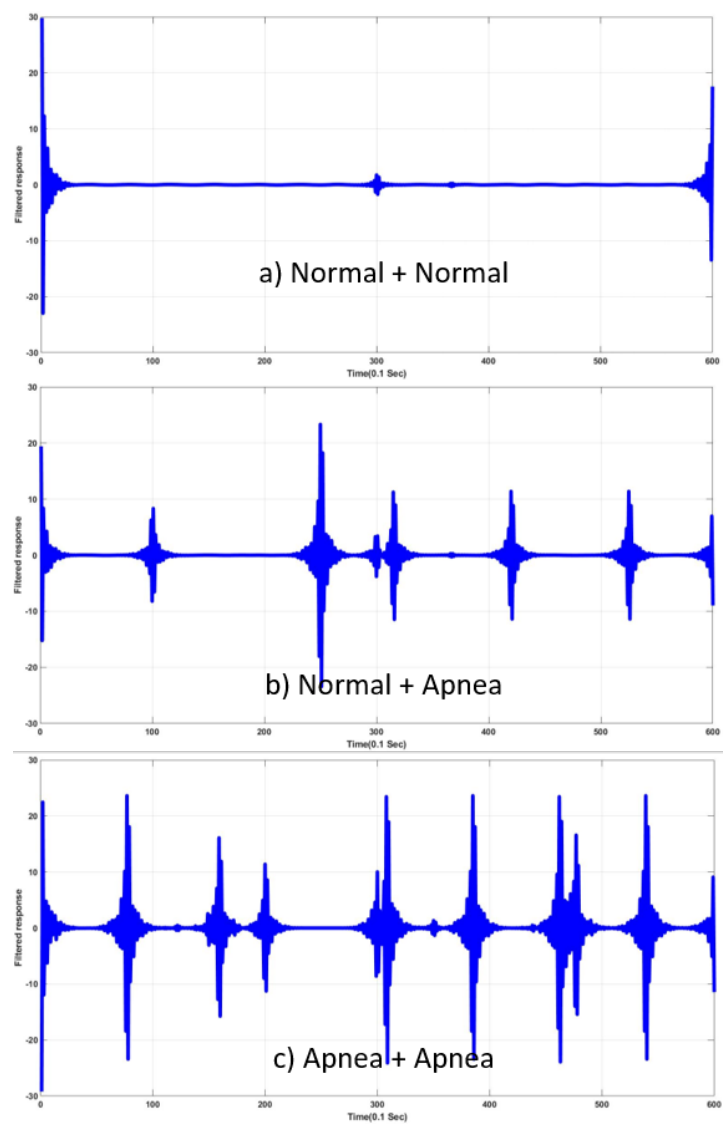
Figure 11. Responses to filter with varying cut-off frequency providing information about existence of abnormal respiration. ( a ) S 1 ( t ) ∗ h c ( t ) . ( b ) S 2 ( t ) ∗ h c ( t ) . ( c ) S 3 ( t ) ∗ h c ( t )